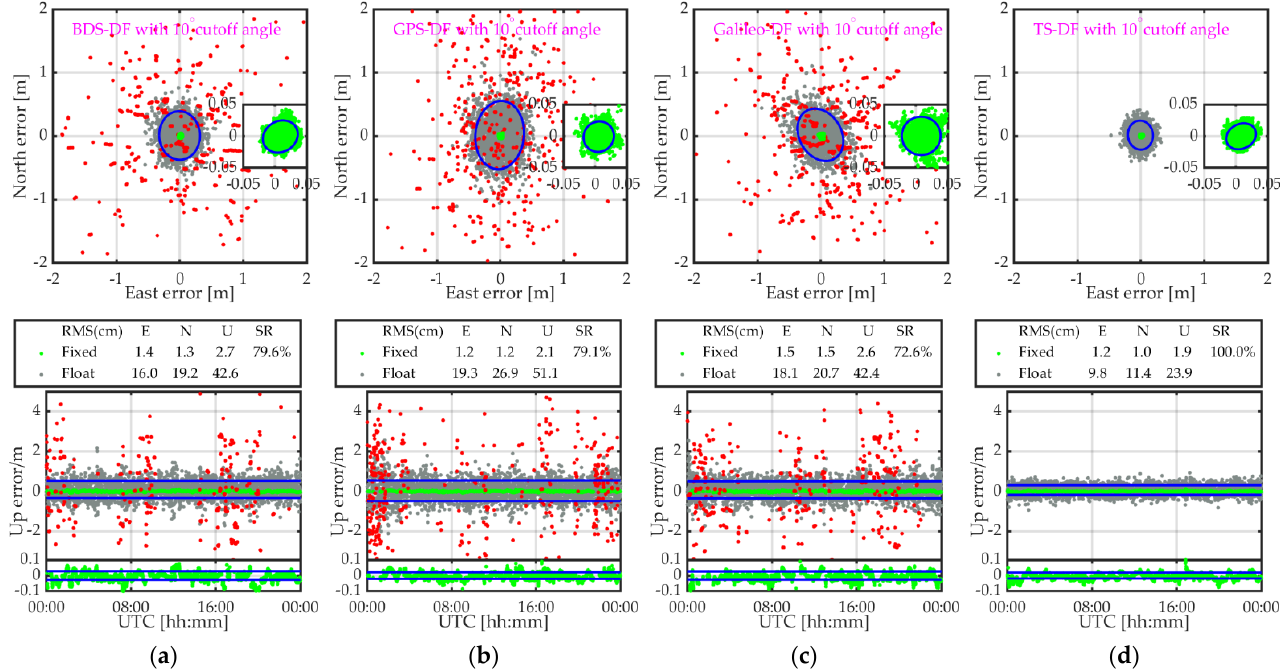
Figure 7. Horizontal scatters ( top ) and vertical time series ( bottom ) of the positioning errors of BDS-3 ( a ), GPS ( b ), Galileo ( c ), and triple-system (TS) ( d ) dual-frequency (DF) RTK of baseline GODE-USN7 on DOY 120, 2021 with a cutoff elevation angle of 10°. On the right of the horizontal scatterplot and on the bottom of the vertical time series, the details of the fixed solutions are displayed with the 95% confidence interval. The float solutions, correct solutions, and incorrect solutions are indicated in grey, green, and red, respectively.